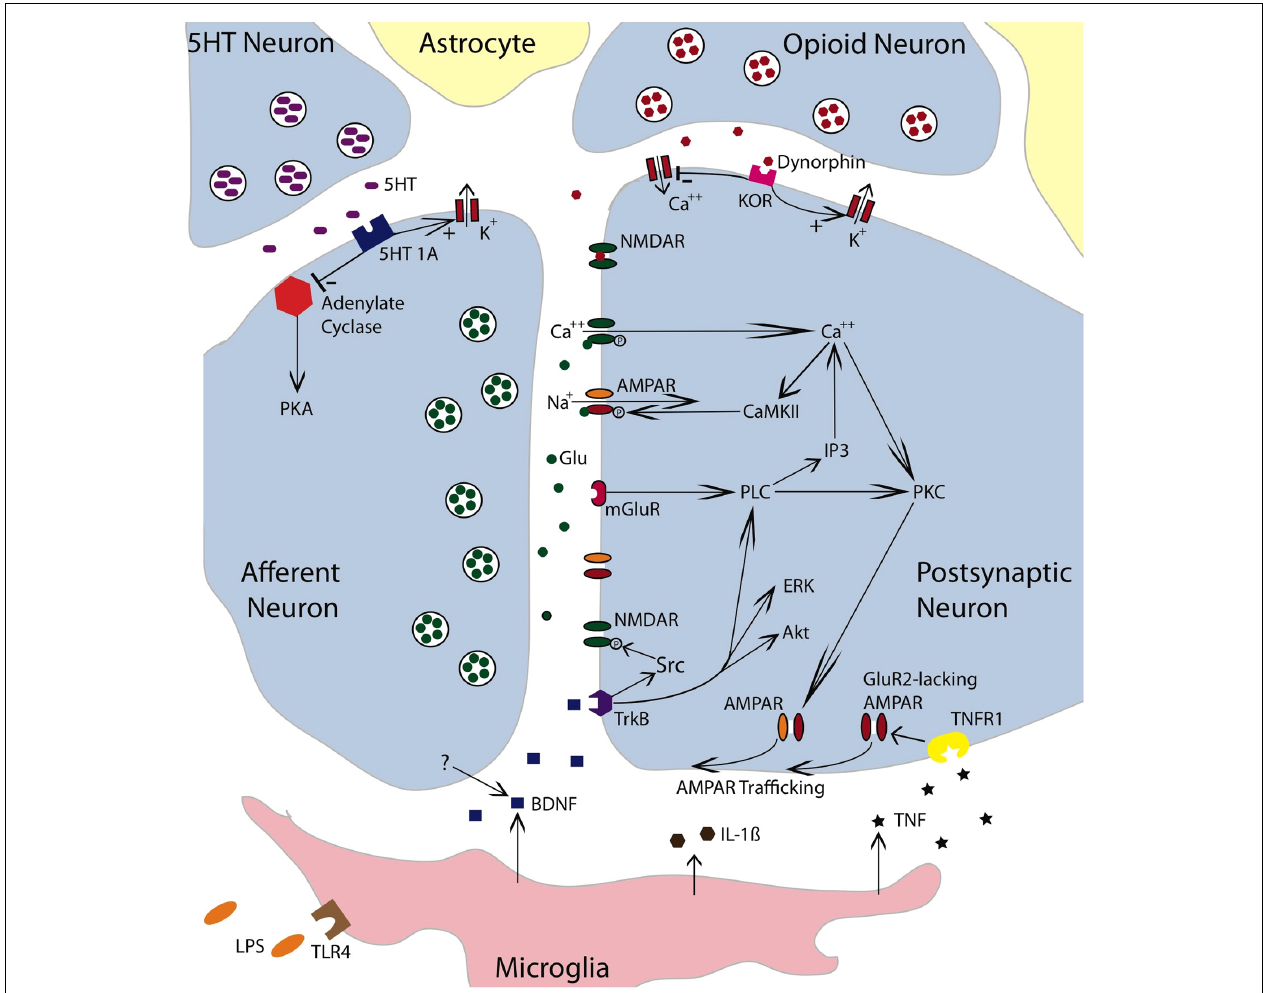
FIGURE 4 | Neurochemical mechanisms involved in spinally mediated learning and metaplasticity. The figure depicts a tripartite synapse involving an afferent neuron, a postsynaptic neuron, and the surrounding astrocytes. The afferent neuron is glutamatergic. Released glutamate (Glu) can engage the NMDAR, AMPAR, or mGluR receptors on the postsynaptic neuron. Activating the NMDAR in conjunction with a strong depolarization allows Ca ++ to enter the postsynaptic cell, which engages intracellular signals such as Ca ++ /calmodulin-dependent protein kinase (CaMKII) and protein kinase C (PKC). CaMKII activates the AMPAR and thereby promotes the entry of Na + . Engaging the mGluR activates phospholipase C (PLC), which engages inositol triphosphate (IP3) and PKC. IP3 initiates the release of intracellular Ca ++ . PKC promotes the trafficking of AMPARs to the active region of the synaptic membrane. To illustrate the relevant pathways, cells that exert a modulatory effect are also indicated. These include a descending serotonergic (5HT) neuron, an kappa opioid neuron, and a microglia. Both the 5HT neuron and opioid neuron would exert an inhibitory effect that could act on either the presynaptic or postsynaptic neuron. Dynorphin released from the opioid neuron would engage the kappa opioid